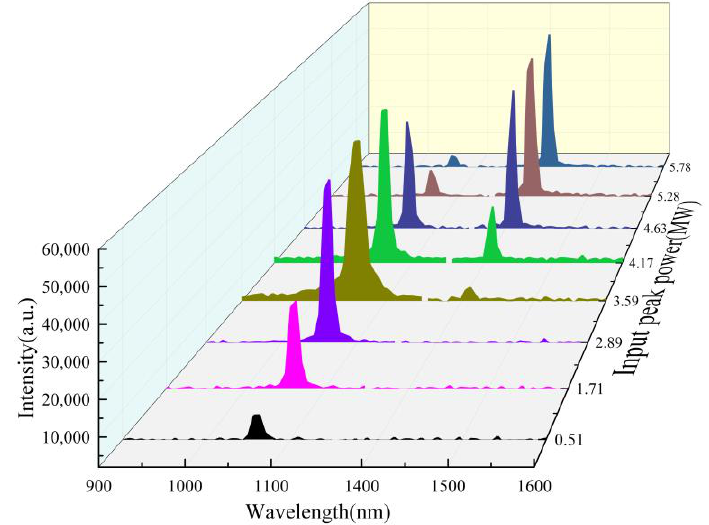
Figure 4. Measured output spectra under air-filled AR-HCF for different incident power.